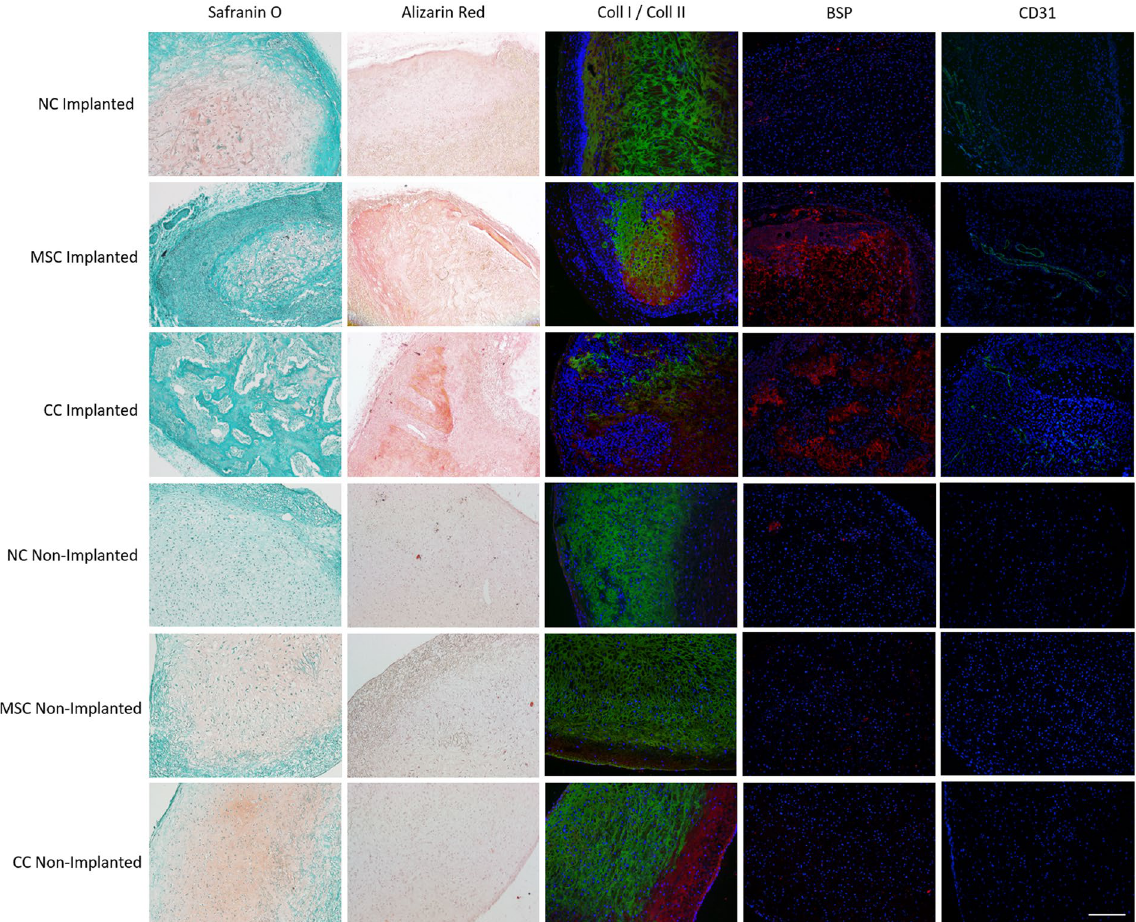
Figure 7. Panel image illustrating the phenotypic stability characteristics of the tissue culture strategies for one donor in normoxic conditions (similar patterns were seen in hypoxia and in Donor 2). From left to right, Fast Green/Safranin O (GAG distribution), Alizarin Red (calcification), immunofluorescence for collagen I and collagen II, bone sialoprotein (BSP), and CD31 - in all fluorescence images DAPI for cell nuclei. The NC condition resulted in no calcification, normal collagen fluorescence and minimal, punctate BSP fluorescence similar to non-implanted controls. There was some vascular invasion as seen by positive CD31 fluorescence but only on the periphery of the construct and not in the cartilaginous region. Both MSC and CC groups demonstrated, very little GAG staining, positive Alizarin staining for calcification, diffuse BSP fluorescence and pervasive CD31 fluorescence throughout the constructs. Scale bar 200 μ